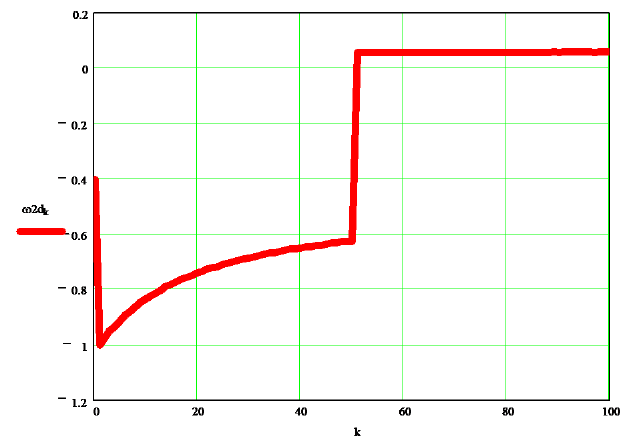
Figure 11. The original dynamic angular velocity w 2 d .